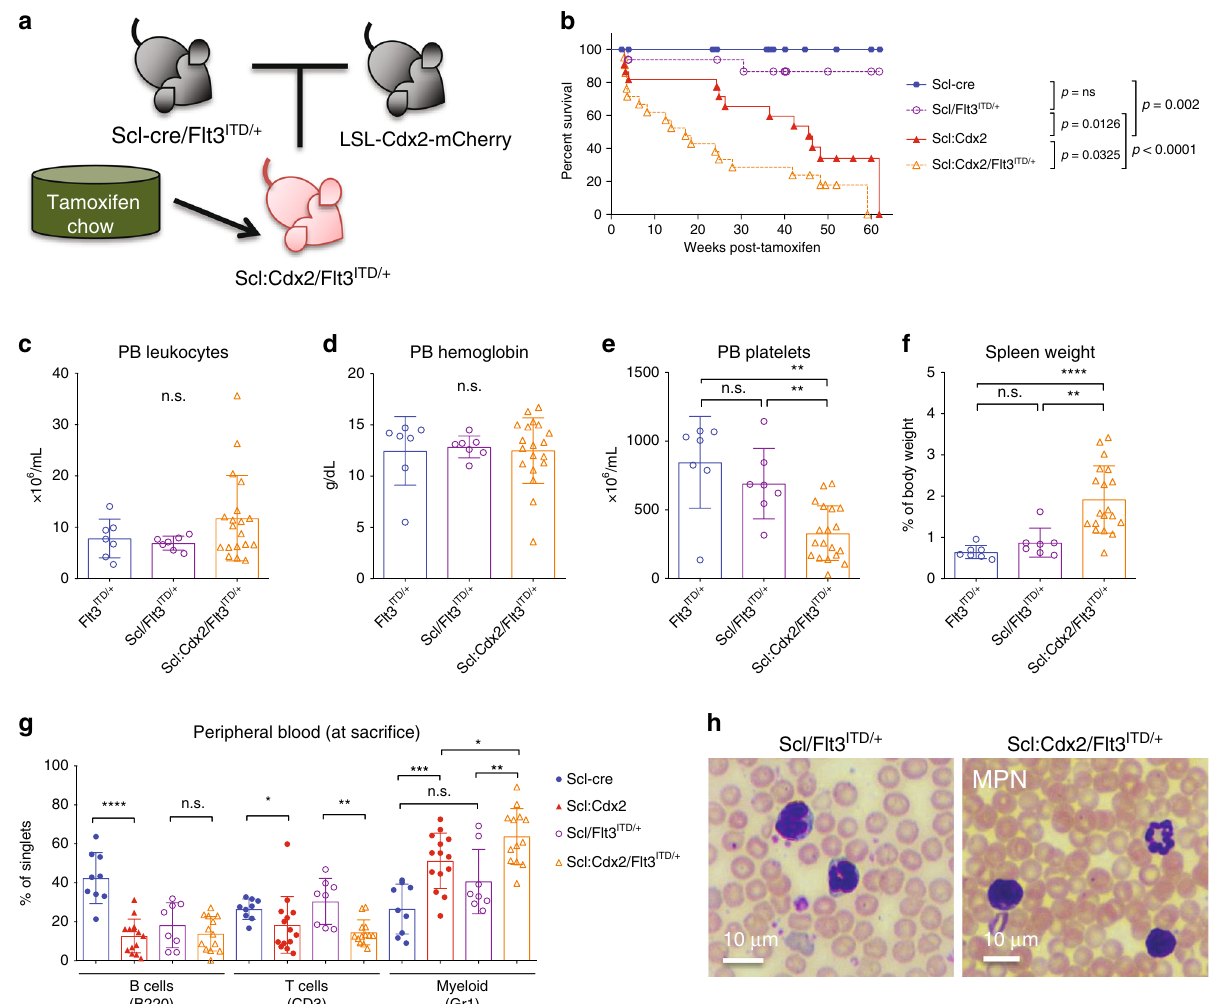
Fig. 3 Cdx2 synergizes with Flt3-ITD to accelerate myeloproliferation. a Diagram of breeding strategy to produce Scl:Cdx2/Flt3 ITD/ + mice. LSL-Cdx2- mCherry mice were crossed with Flt3 ITD/ + germline mutant mice that were previously crossed with Scl -CreER T transgene mice (Scl-cre/Flt3 ITD/ + ). Unexcised Scl:Cdx2/Flt3 ITD/ + mice are fed tamoxifen-loaded chow for two weeks. b Survival curve of tamoxifen-treated mice ( Scl -CreER T n = 18; Scl:Cdx2 n = 22; Scl/Flt3 ITD/ + n = 16; Scl:Cdx2/Flt3 ITD/ + n = 21). c PB leukocytes (WBC), d hemoglobin and e platelet counts of mice, and ( f ) spleen size relative to body mass of mice at sacri fi ce (Flt3 ITD/ + n = 7; Scl/Flt3 ITD/ + n = 7; Scl:Cdx2/Flt3 ITD/ + n = 19). g Frequency of B220-positive B cells, CD3-positive T cells and Gr1-positive myeloid cells in PB of mice at sacri fi ce ( Scl -cre n = 9; Scl:Cdx2 n = 14; Scl/Flt3 ITD/ + n = 8; Scl:Cdx2/Flt3 ITD/ + n = 13). h Representative Wright-Giemsa stained smear of Scl/Flt3 ITD/ + PB with mild granulopoiesis and Scl:Cdx2/Flt3 ITD/ + PB showing monocytosis and hypersegmented neutrophils resulting in MPN (observed in multiple independent animals). Scale bars on bottom left of each image indicate 10 µ m. N = biologically independent animals. Statistical analyses performed using two-tailed Mann – Whitney test. Log-rank Mantel-Cox test used for survival curve. Data are plotted as mean values + / − SD. n.s.; not signi fi cant. * P < 0.05, ** P < 0.01, *** P < 0.001, **** P <